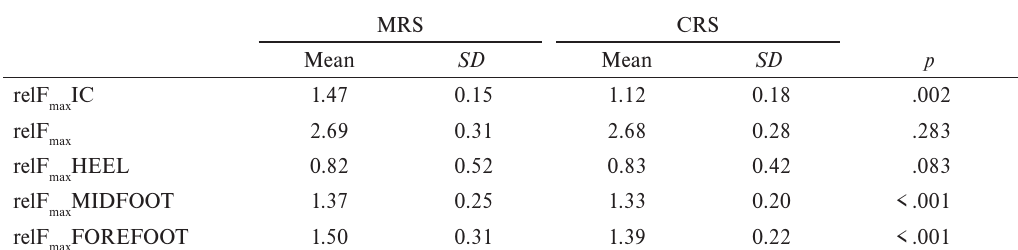
Foot loading (normalized to body weight) while running in minimalist and conventional running shoes MRS